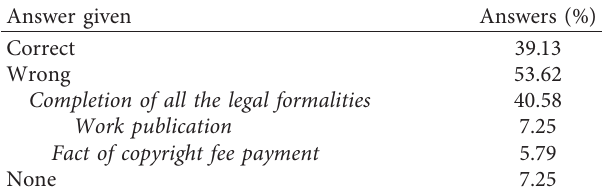
Table 5: Copyright